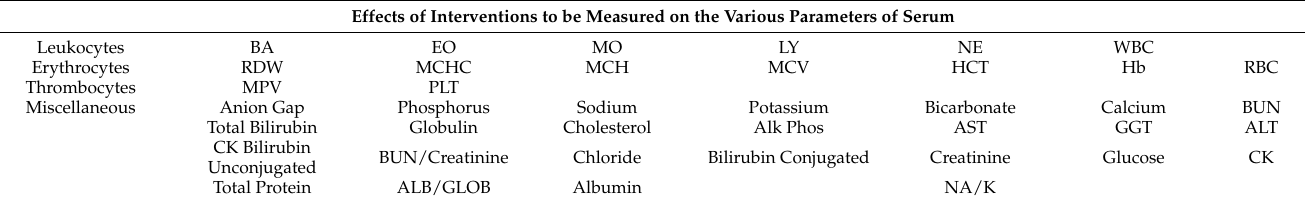
Table 3. Toxicity and inflammation effects of interventions to be measured by the various parameters of serum. Effects of Interventions to be Measured on the Various Parameters of